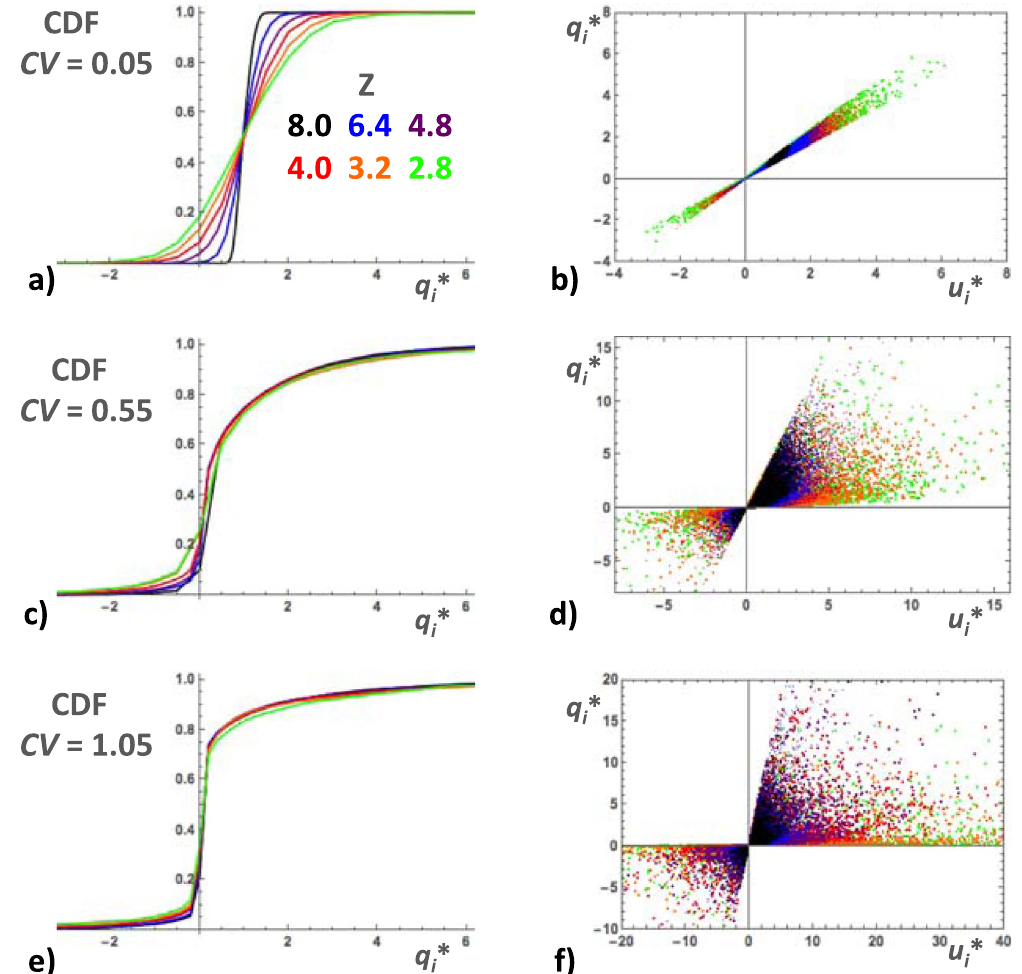
Figure 7. Examples of the cumulative distribution function of q i * in BCC simulations with CV = 0.05 ( a ), 0.55 ( c ) and 1.05 ( e ). In each diagram, the CDF’s corresponding to different coordination numbers ( Z = 8.0, 6.4, 4.8, 4.0, 3.2 and 2.8) are represented by colored lines as indicated in the inset. Scatterplot of q i * versus u i * for the same simulations, CV = 0.05 ( b ), 0.55 ( d) and 1.05 ( f ). Layers of colored data-points are superposed with the ones corresponding to Z = 8 on top and Z = 2.8 at the bottom. (See text for more